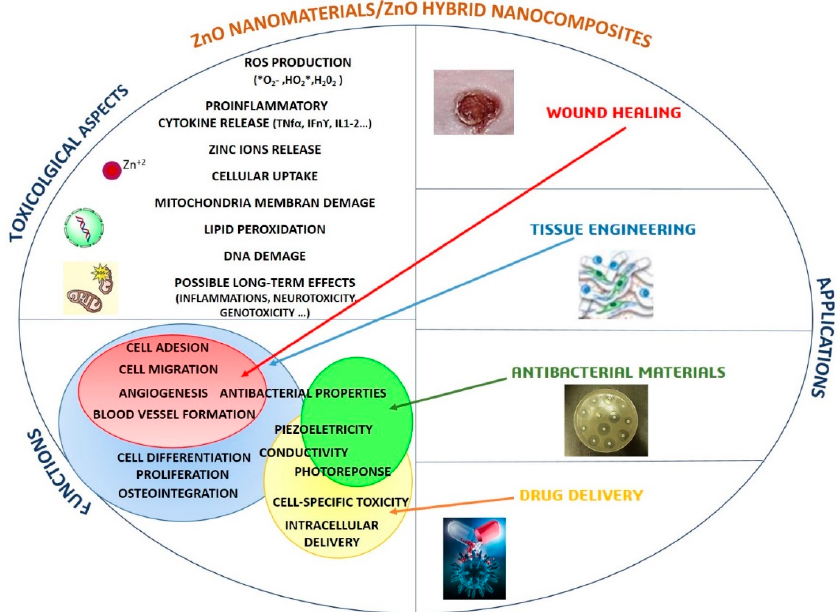
Figure 2. Toxicological aspects, functions, and scope of applications of ZnO-based nanomaterials and ZnO hybrid nanocomposites.